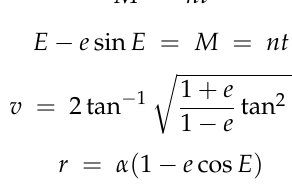
Figure 4. The geometric relationship between M and v .